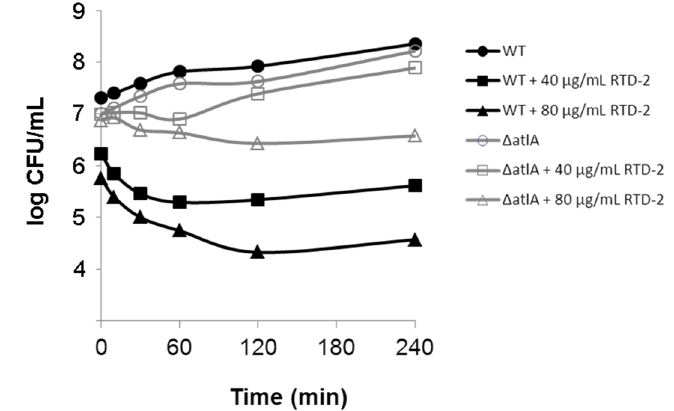
Figure 6. Killing kinetic of S. aureus SA113 (WT) and its atl deletion mutant (Δatl) in presence of 40 and 80 μg/mL RTD-2 (corresponding to 5× and 10× MIC, respectively) over a period of 4 h. The first sample was taken immediately after peptide addition (time point 0). The results given are mean values of at least two independent